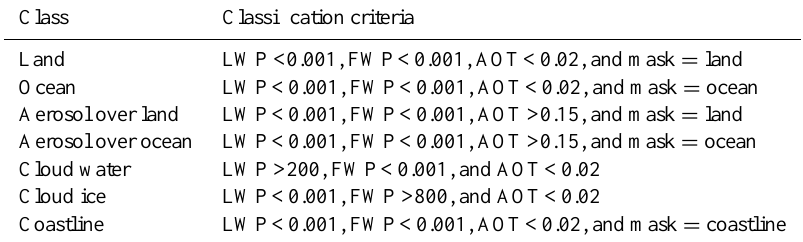
Table 2. Classification criteria.